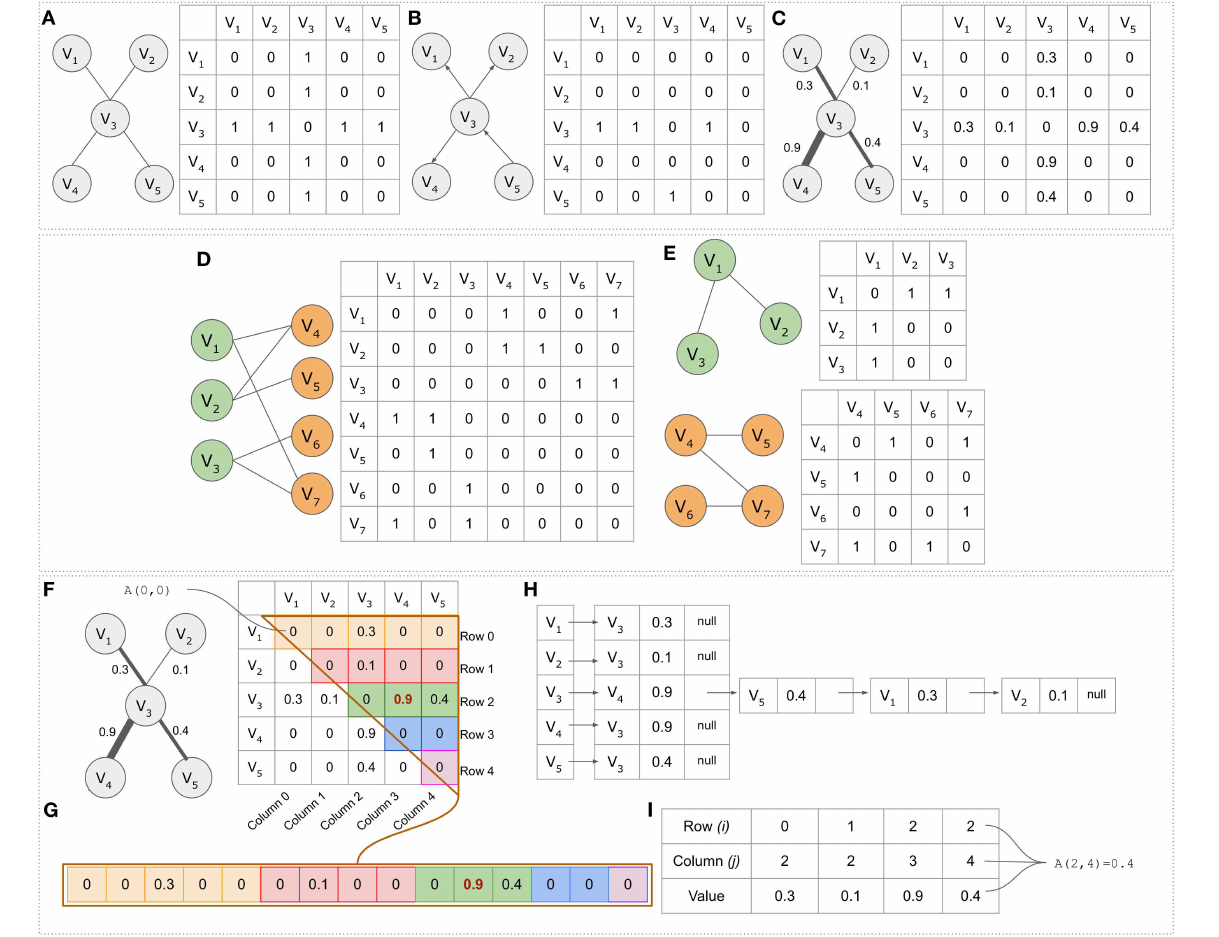
( Figure 3A ). Looking at all nodes in a